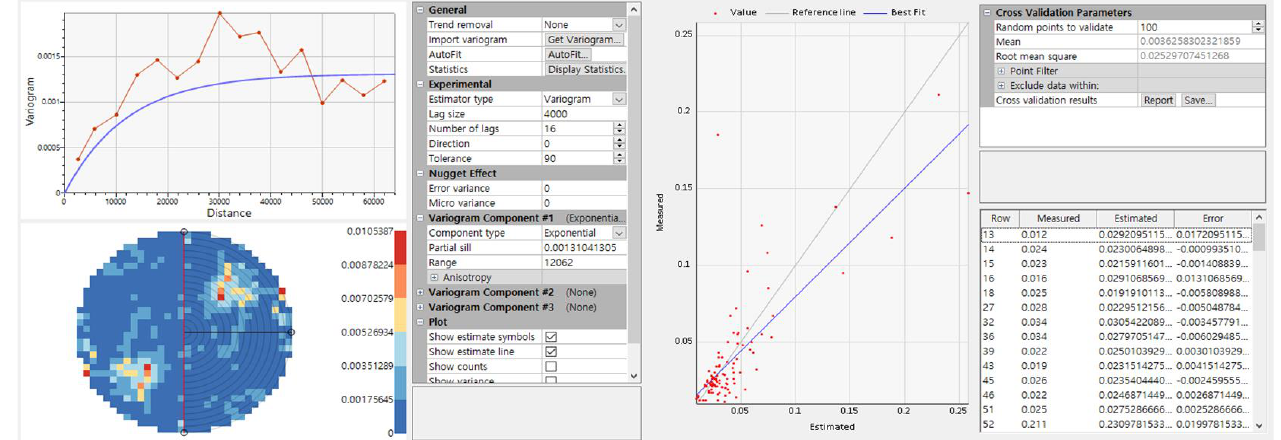
Figure 14. Parameters that constitute the exponential variogram in the Surfer software. Empirical variogram: a set of variogram values for separation distances at regular intervals (actual variogram) → (red dot). Theoretical variogram: an expression of the empirical variogram (modeled variogram) → (blue line).